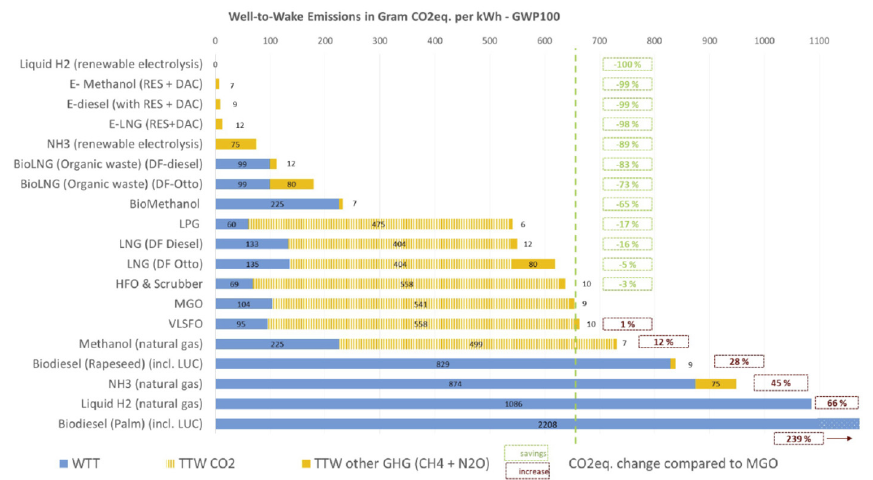
Figure 7. Assessment of fuels based on GHG reduction potential. Source: [36].